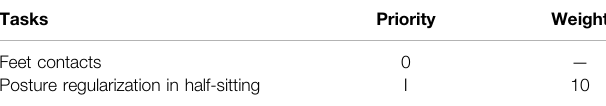
TABLE 9 | Set of tasks for the torque control scheme on the posture task. Tasks